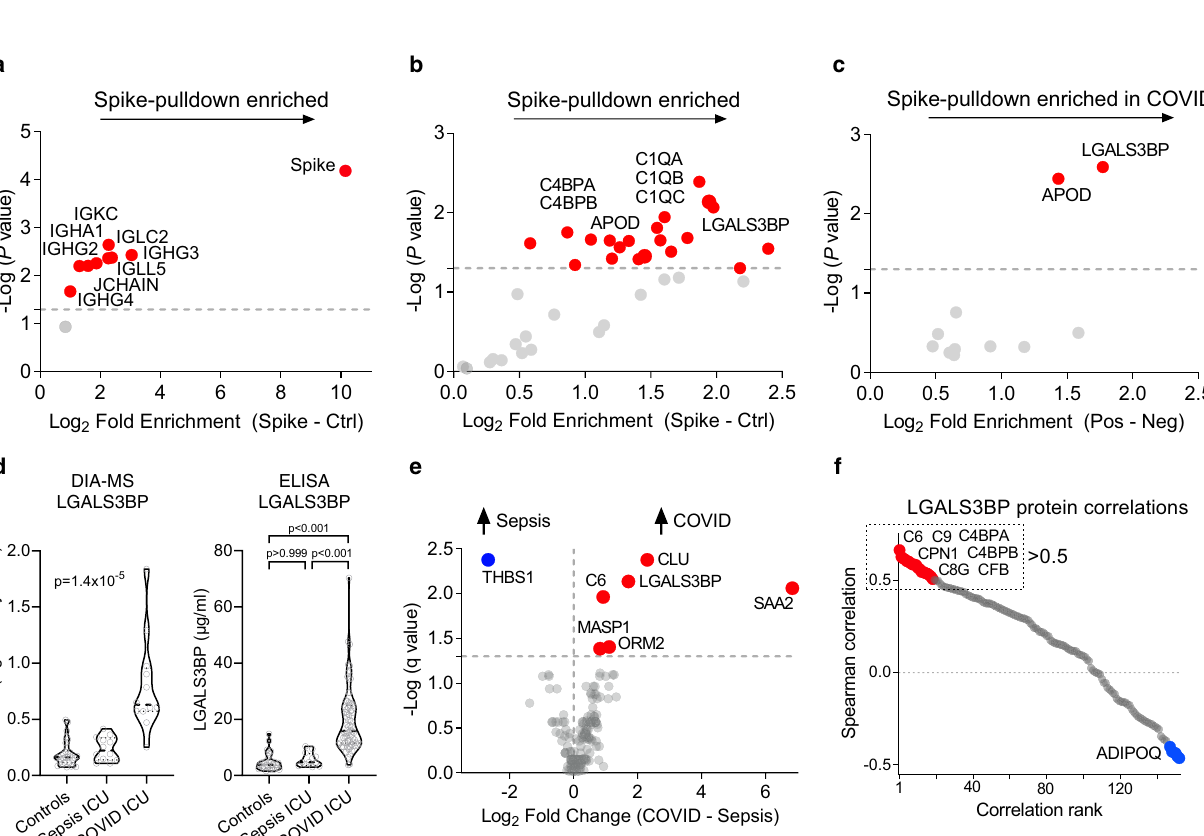
Fig. 6 Circulating protein changes associated with SARS-CoV-2 RNAemia over time. a DIA – MS analysis upon serum samples from the GSTT COVID-19 ICU cohort was used to determine proteins that associate with the presence of SARS-CoV-2 RNAemia at baseline ( n = 9 positive, n = 38 negative). Proteins that were signi fi cantly associated with RNAemia at baseline are individually represented as violin plots. Signi fi cance was determined through the Limma linear model analysis using Benjamini and Hochberg ’ s FDR correction. b Proteins with signi fi cantly different trajectories over time (baseline, week 1 — time point 1, week 2 — time point 2) between RNAemia positive and negative patients ( n = 9 positive patients, n = 38 negative patients with samples in each of the three-time points, totaling n = 141 samples). PIGR polymeric immunoglobulin receptor, KLKB1 kallikrein B1. The median and 95% CI of the median is shown. Unadjusted for multiple comparisons. c Serial serum samples from COVID-19 ICU patients (GSTT, baseline, week 1 and week 2, n = 10 nonsurvivors, n = 37 survivors with samples in each time point, totaling 141 samples) were analyzed by DIA – MS to determine protein changes over time in ICU. The heat map represents a hierarchical cluster analysis conducted upon a Spearman correlation network of signi fi cantly changing proteins over time in ICU, applying row-wise corrections for multiple testing using the Benjamini-Hochberg FDR correction. Comparison of the trajectories of protein clusters in COVID-19 ICU patients based on 28-day mortality is also shown. Gene ontology enrichment analysis was used to determine functional pathways associated with the distinct protein clusters identi fi ed. Listed are the protein clusters that show a signi fi cant change between 28-day survivors (gray) and nonsurvivors (red) — and having signi fi cant interaction with time points (baseline, week 1 — time point 1, week 2 — time point 2). Lines show nonlinear regression curves with gray bands indicating the 95% CI. P values represent the signi fi cance of the outcome term in a fi tted GAM model when correcting for age and sex. All statistical analyses are two-tailed.